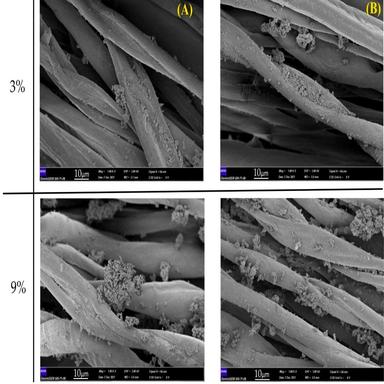
SEM images comparing undoped cotton ring spun yarns with PCM(3 %)-Cott and PCM(9 %)-Cott yarns produced at different nanocapsule concentrations and feeding rates (A: 62.5 ml/h and B: 80 ml/h) (1.00 kx).